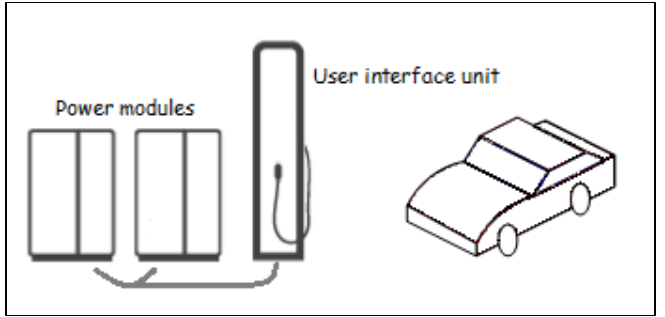
Figure 1. Scheme of a high-power charging system (HPCS).